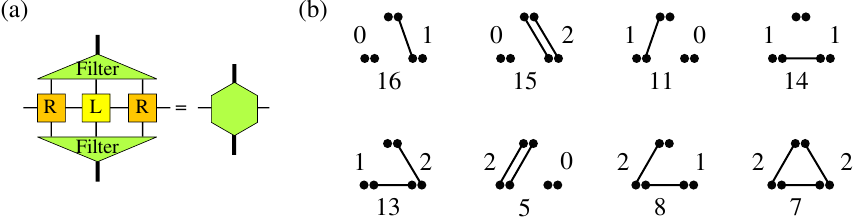
Figure 20: (a) Graphical representation of the three-site MPO. The filter tensor selects states that do not violate the QLM constraints. (b) Sketch of all possible states of the filtered three-site MPO in (a). The numbers on the left and right of each sketch indicate the quantum number of the left and right environments respectively. The number below is the index of each configuration in the full three-site Hilbert space (the first vector has index